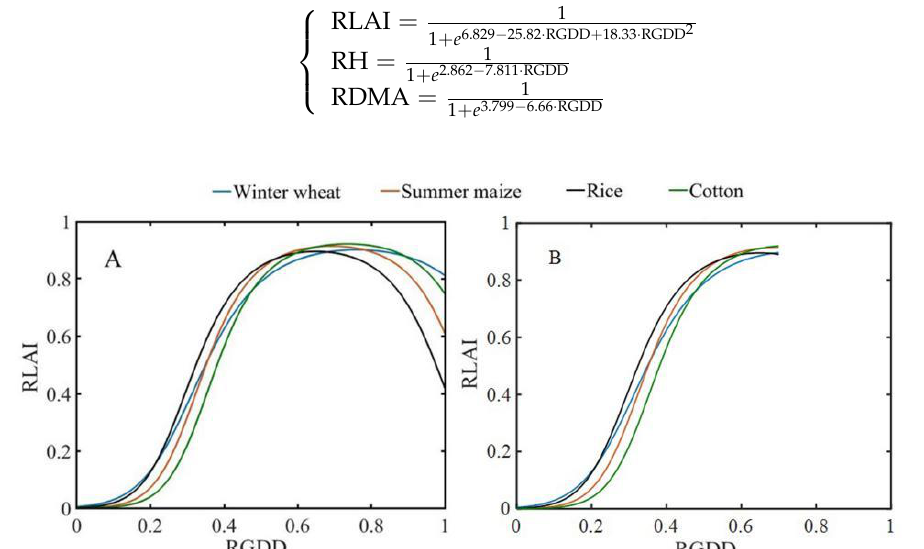
Figure 6. Modified fully relative logistic curves of the leaf area index (RLAI) for the crops for ( A ) increases and decreases and ( B ) increases. RGDD for winter wheat was calculated starting from the rising period.